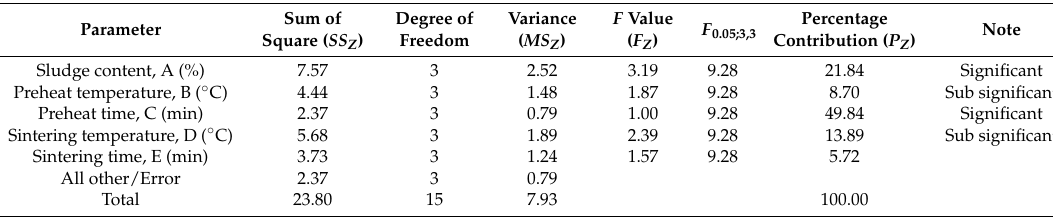
Table 13. Analysis of variance and F test for loss on